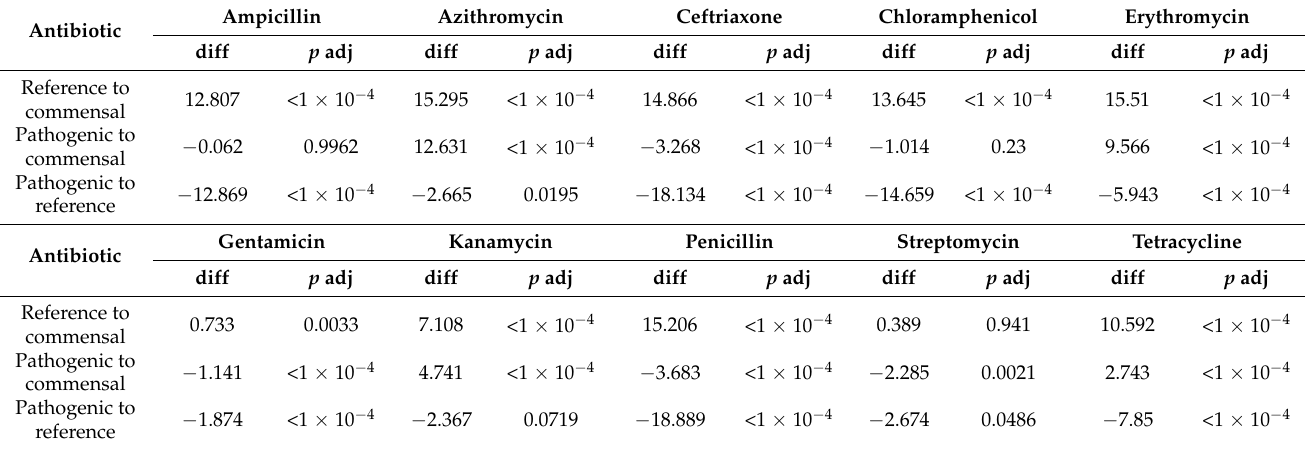
Table 2. One-way ANOVA multiple pairwise comparisons displaying the difference and the adjusted p -value of ZoI diameter means for 3 groups (commensal, reference, pathogenic) for each antibiotic. For this analysis, we selected a conservative alpha threshold of <1 × 10 − 4 given that we are comparing 10 different